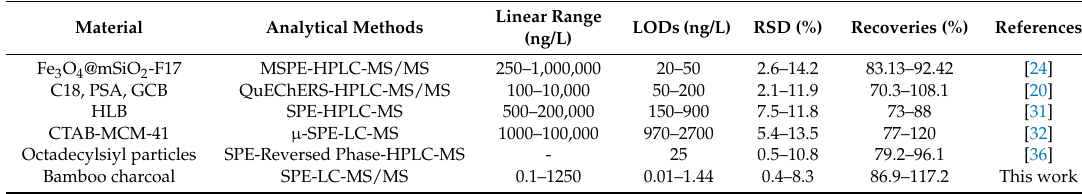
Table 2. Method comparisons for the analysis of the six PFAAs.